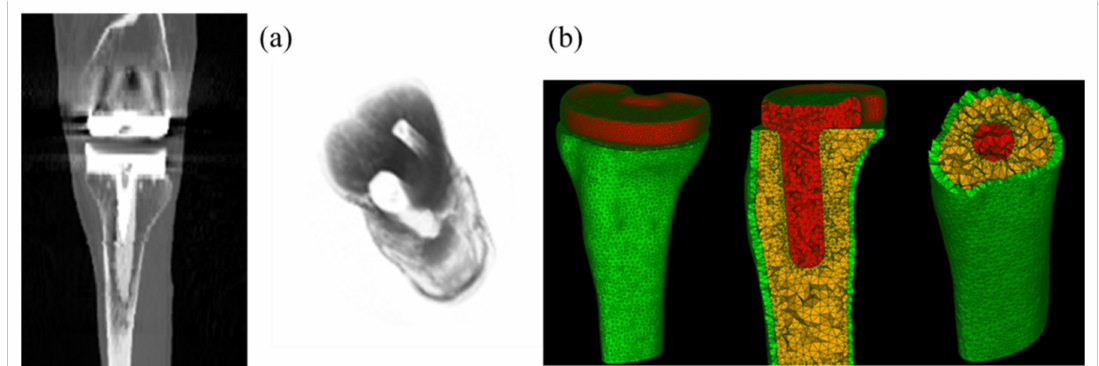
Figure 2. CT images of the human knee with total knee replacement (TKR) implant of the patient ( a ) and associated meshed models of the tibia bone (cortical and cancellous bones corresponding to the green and yellow parts) and implant (the red part) ( b